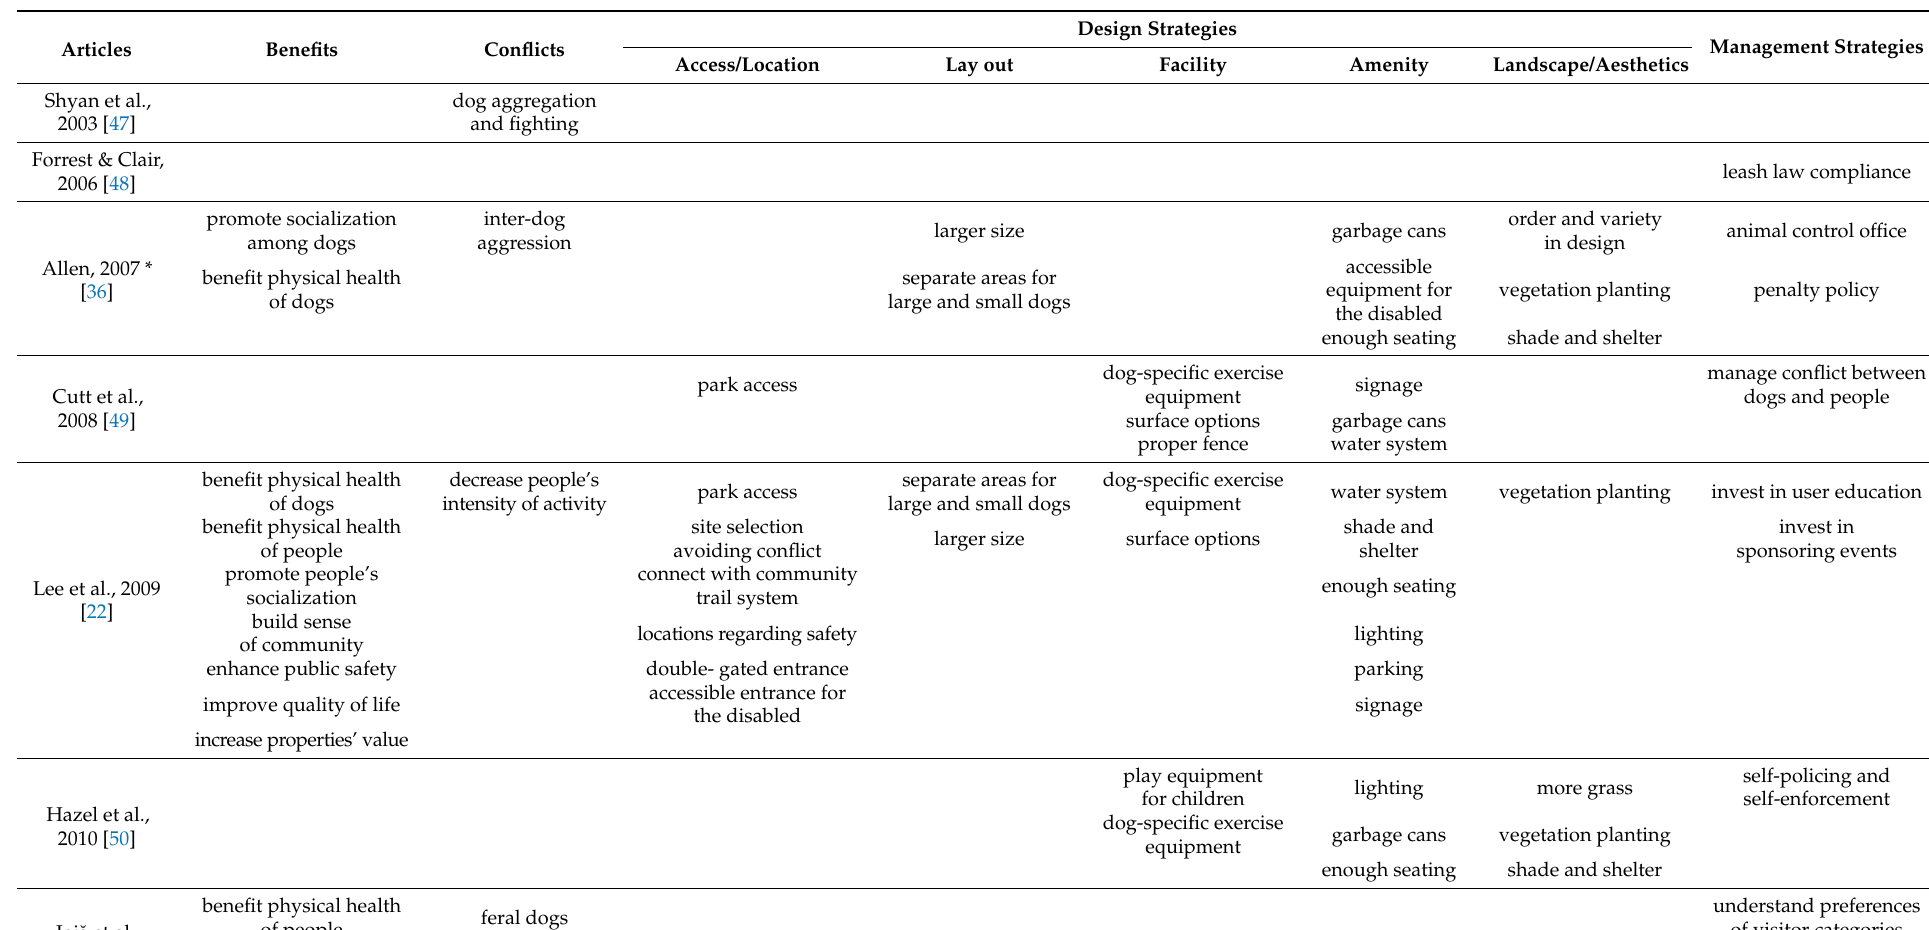
Table 1. Summary of the studies exploring pros and cons and/or the design/management strategies of dog